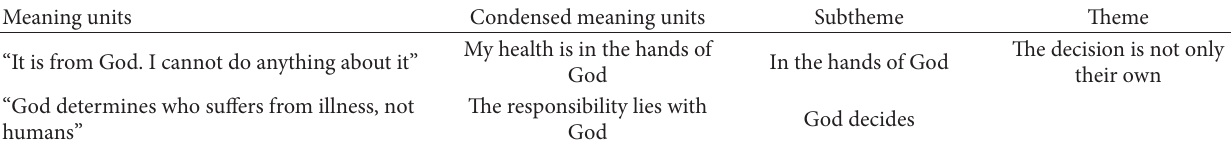
Table 1: Examples of meaning units, condensed meaning units, subtheme, and theme in the analysis.